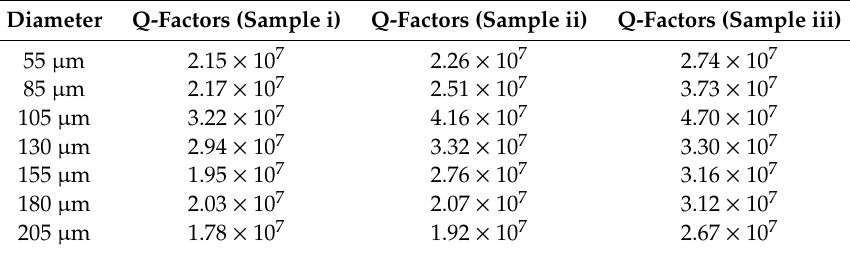
Table 1. Q factors of the microdisks with different diameters.